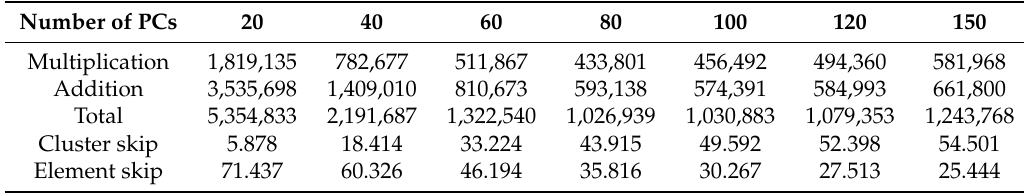
Table 4. CS results according to number of